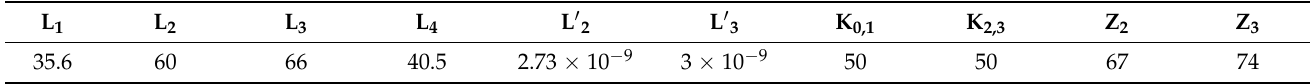
Table 2. Parameter values of the 5 GHz filter different elements from the synthesis.